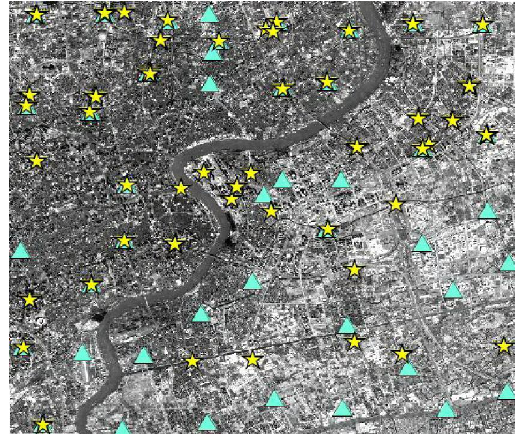
Fig. 1. Configuration of GCPs (stars) and CKPs (triangles)